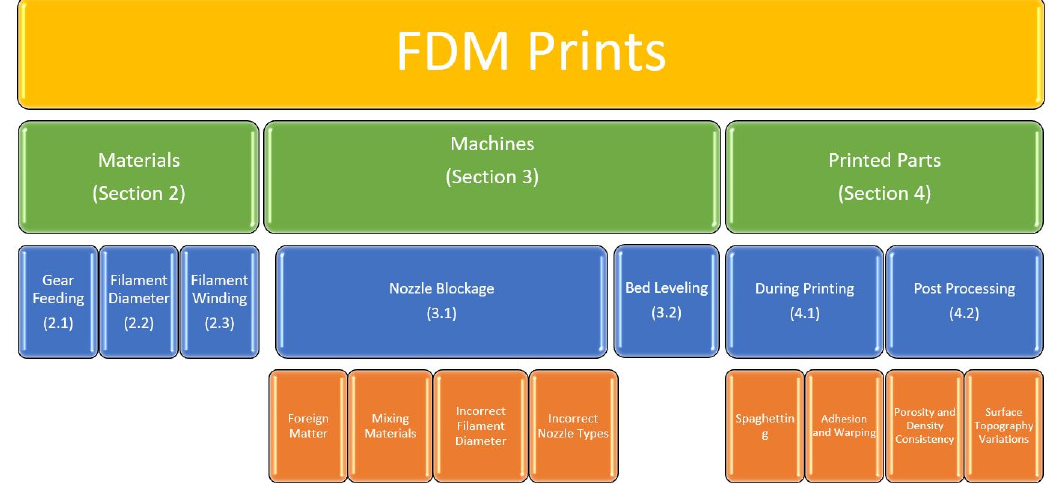
Figure 2. Common defects posed by the FDM printing of polymers and composites.